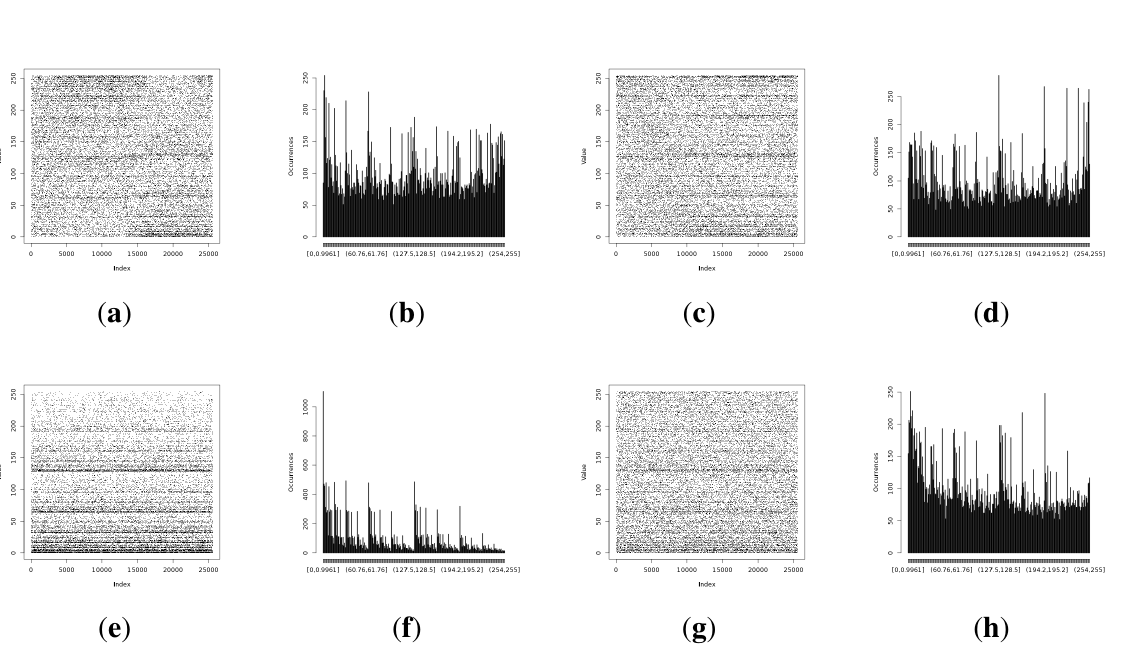
Figure 14. Statistical fine-tuning experiment results for the entropy harvested. ( a ) Light (1) sensor entropy; ( b ) distribution from the Light (1) sensor; ( c ) Light (2) sensor entropy; ( d ) distribution from the Light (2) sensor; ( e ) humidity sensor entropy; ( f ) distribution from the humidity sensor; ( g ) temperature sensor entropy; ( h ) distribution from the temperature